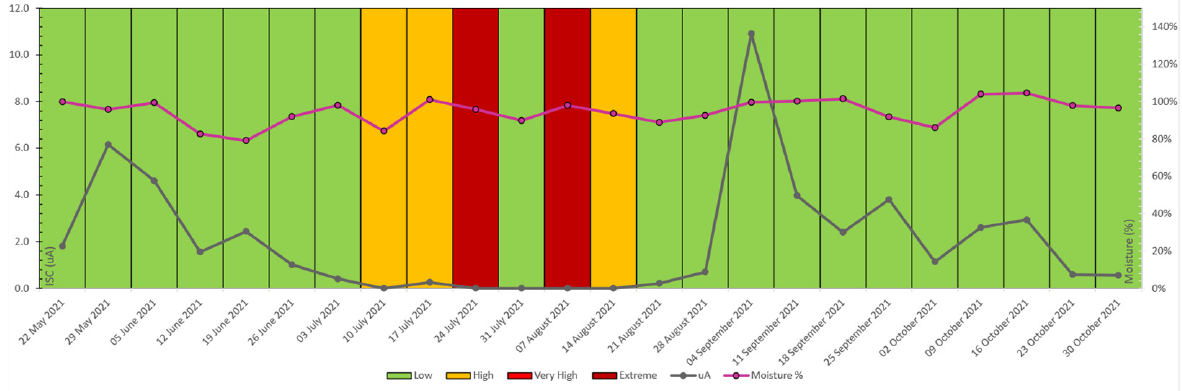
Figure 9. Mean values of ISC (tagged uA in the figure with a dark grey line) and BBMC% (pink line) vs. FWI classification of the measurements according to FWI criteria during the 24 weeks study (background colour).